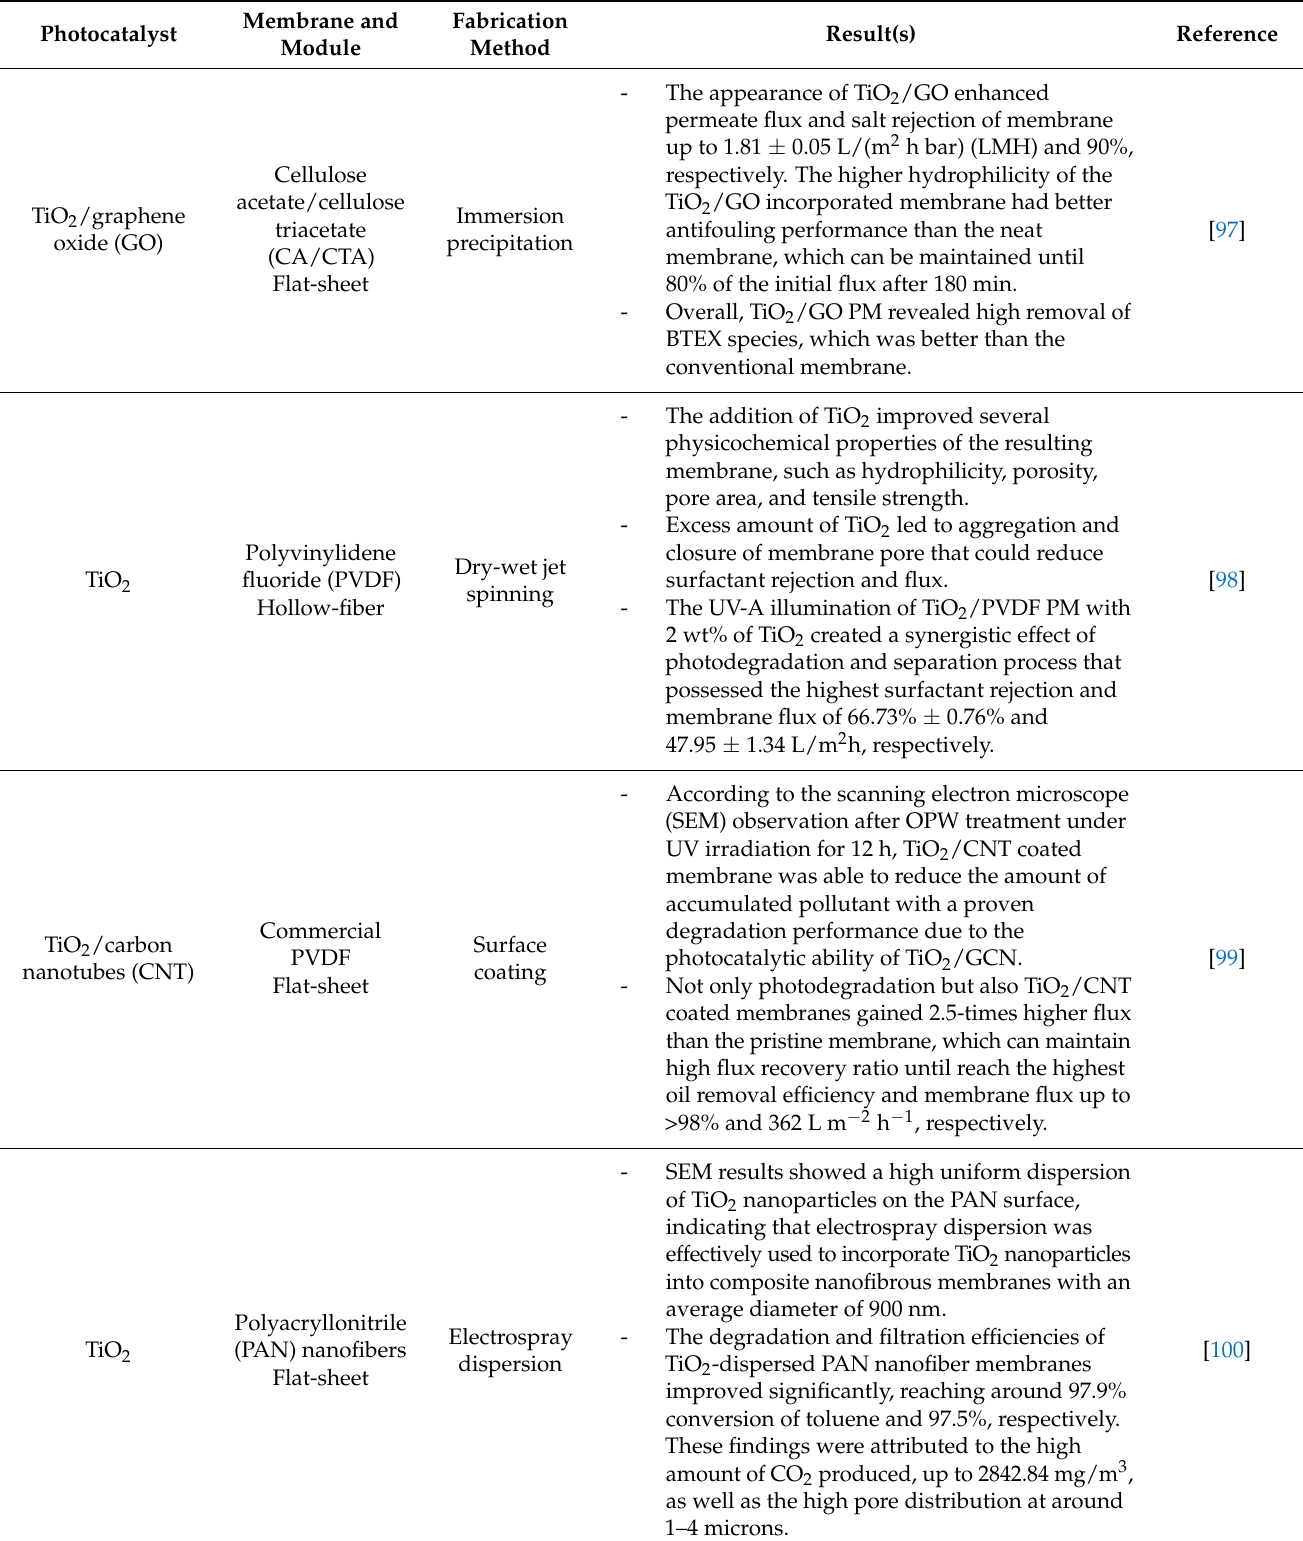
Table 7. The recent advance of TiO 2 -based